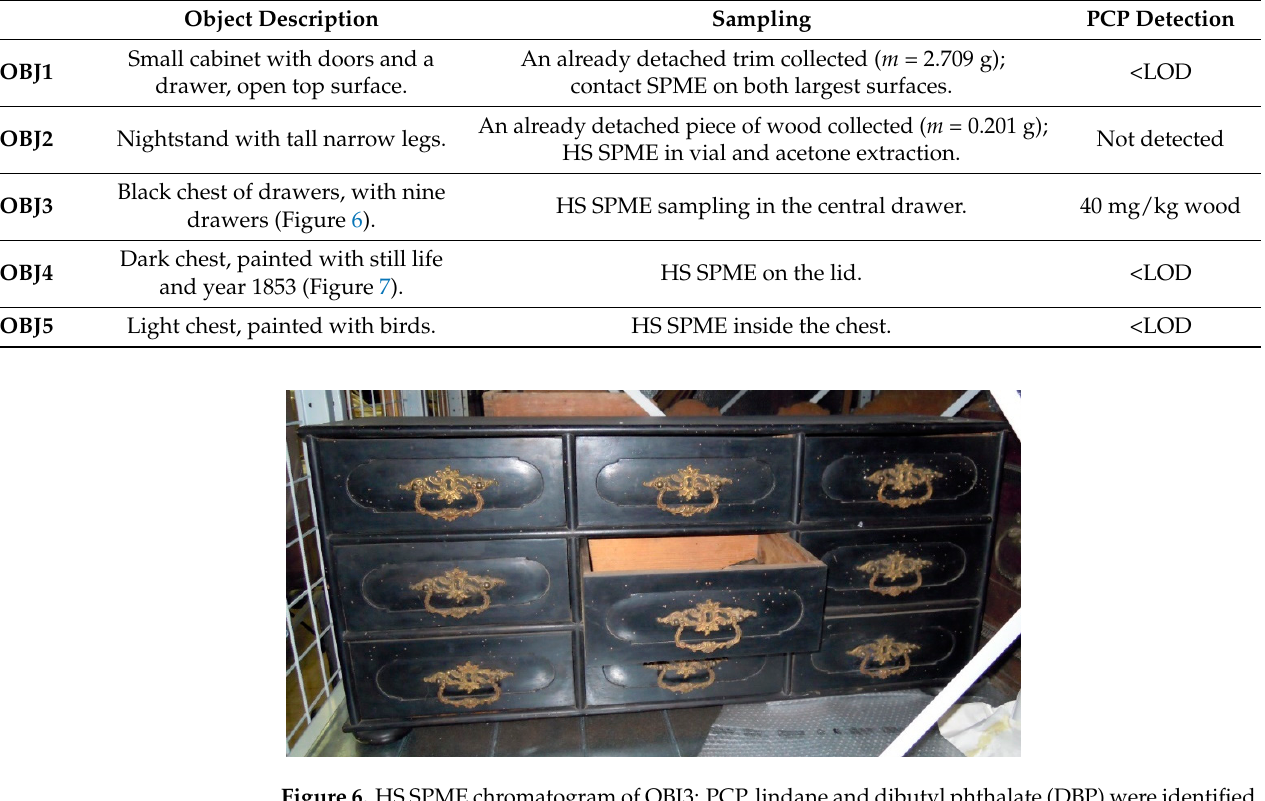
Table 2. Description of the museum objects examined, sampling methods used and the PCP detection.